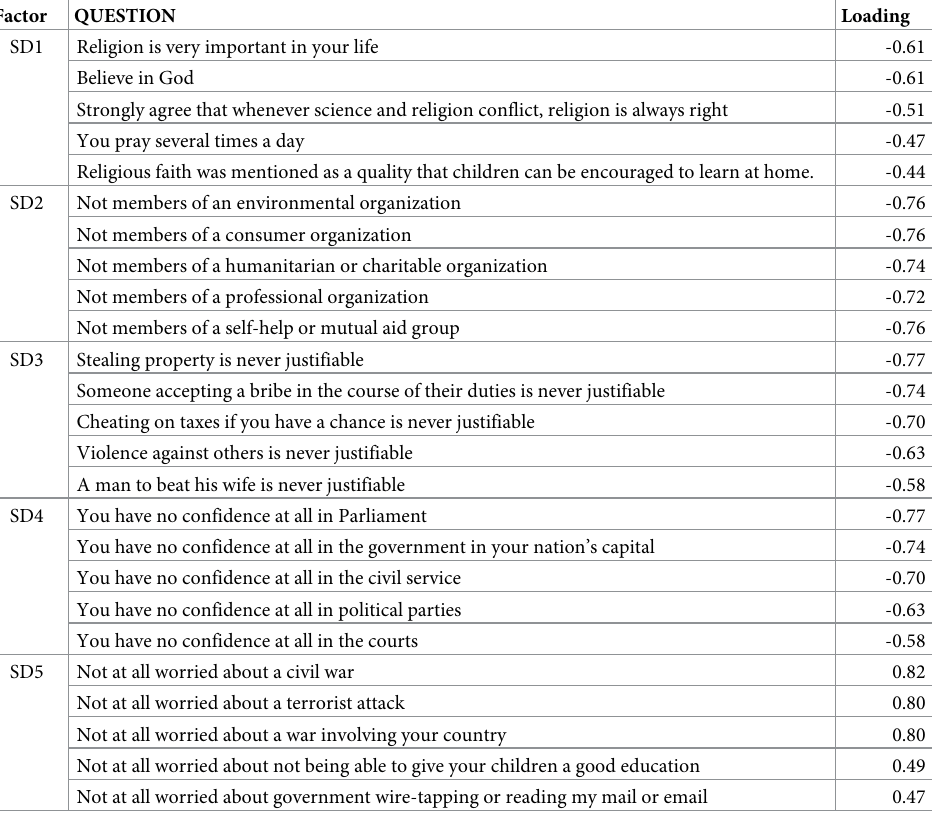
Table 2. Confirmatory Factor Analysis (CFA): Top 5 question loadings on social